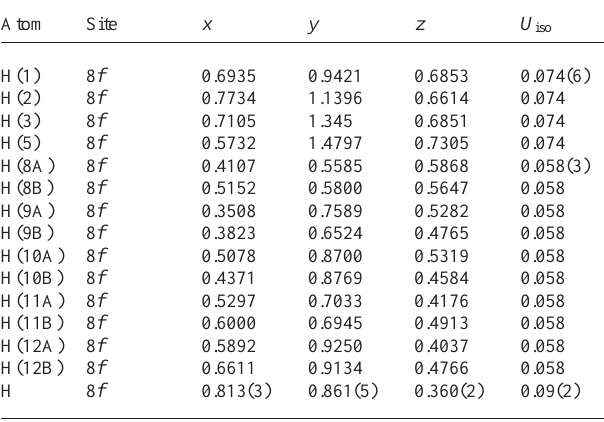
Table 2. Atomic coordinates and displacement parameters (in Å 2 )